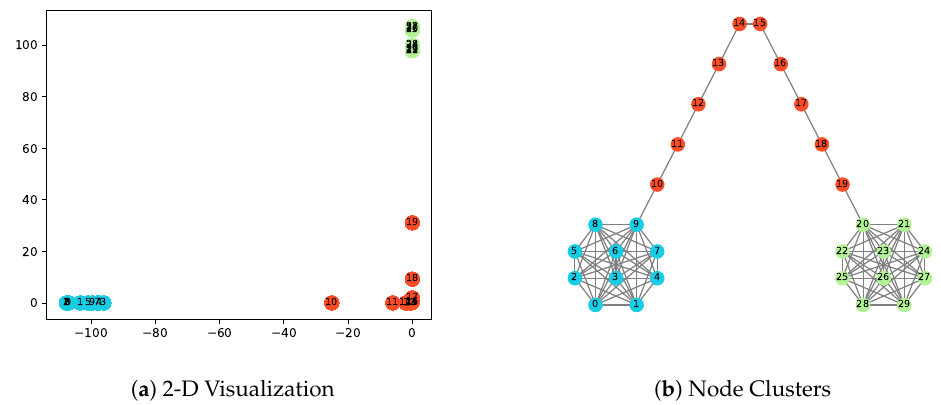
Figure 1. The illustration of the barbell network and obtained node representations in 2-dimensional space with r = 0.5. Nodes in different clusters obtained by the k-means algorithm are marked in different